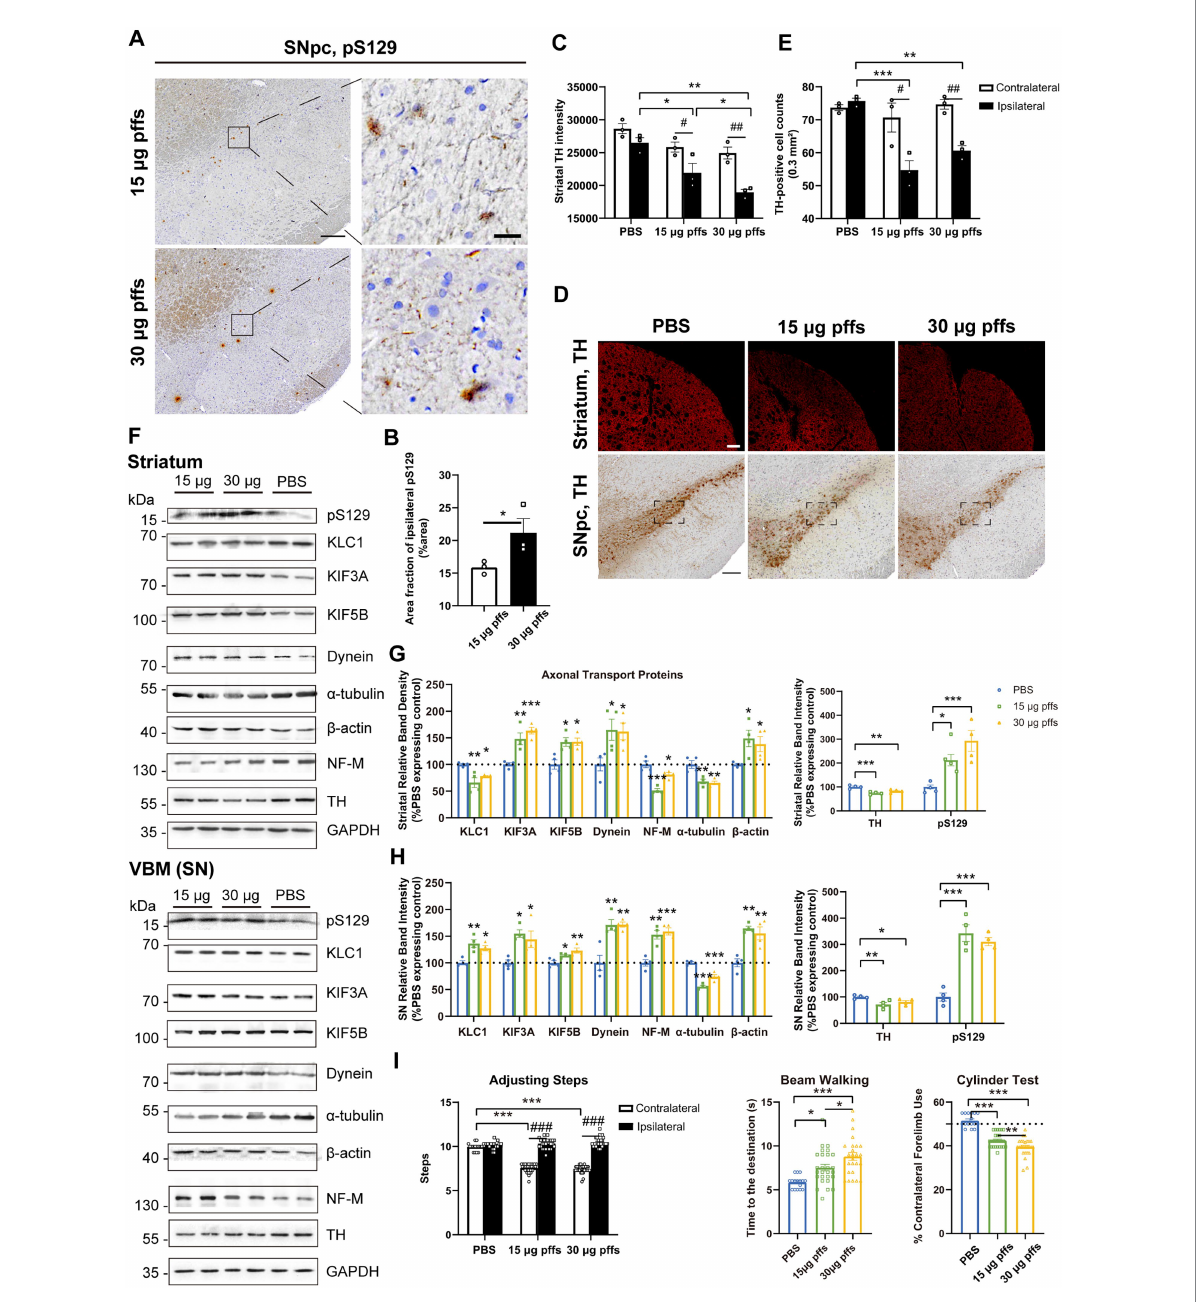
FIGURE 5 Evaluation of the nigrostriatal pathway at 2 months post injection. (A) α -Syn pS129 expression in the SNpc. Scale bar = 200 μ m (left) and 20 μ m (right). (B) The area fractions of the ipsilateral α -Syn pS129 were quantified by ImageJ ( n = 3; * p < 0.05). (C) Fluorescent densitometry of striatal TH ( n = 3; * p < 0.05, ** p < 0.01; # p < 0.05, ## p < 0.01). (D) TH-positive cells in the SNpc and striatum. Scale bar = 200 μ m. (E) TH-positive cells in the SNpc were quantified by counting ( n = 3; * p < 0.05, ** p < 0.01, *** p < 0.001; # p < 0.05, ## p < 0.01. (F) Representative western blot of nigrostriatal changes. (G,H) Quantitative analysis of the afore-mentioned proteins (* p < 0.05, ** p < 0.01, *** p < 0.001; n = 4). (I) Evaluation of behavioral changes ( n = 25; * p < 0.05, ** p < 0.01, *** p < 0.001; ### p < 0.001). All of the data was shown as means ±